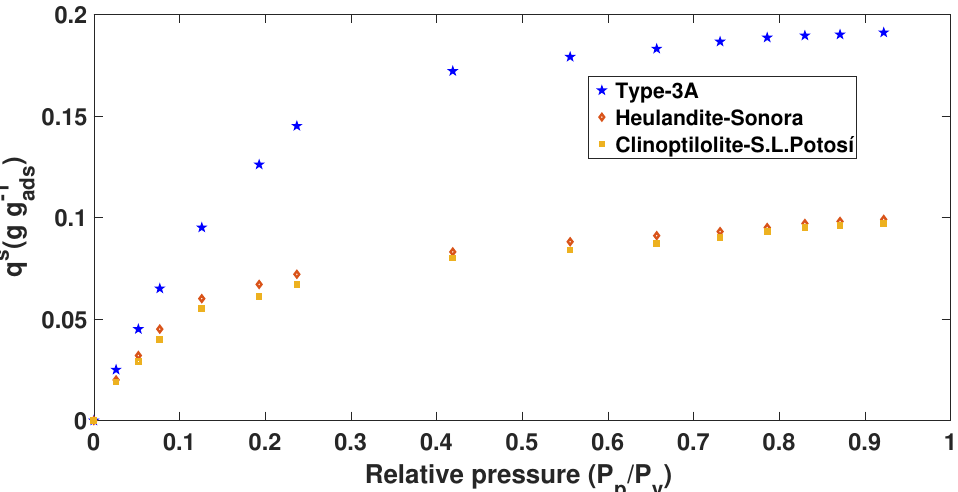
Figure 3. The 50 ◦ C Adsorption isotherm ( H 2 O / C 2 H 5 OH mixture) of Brunauer–Emmett–Teller